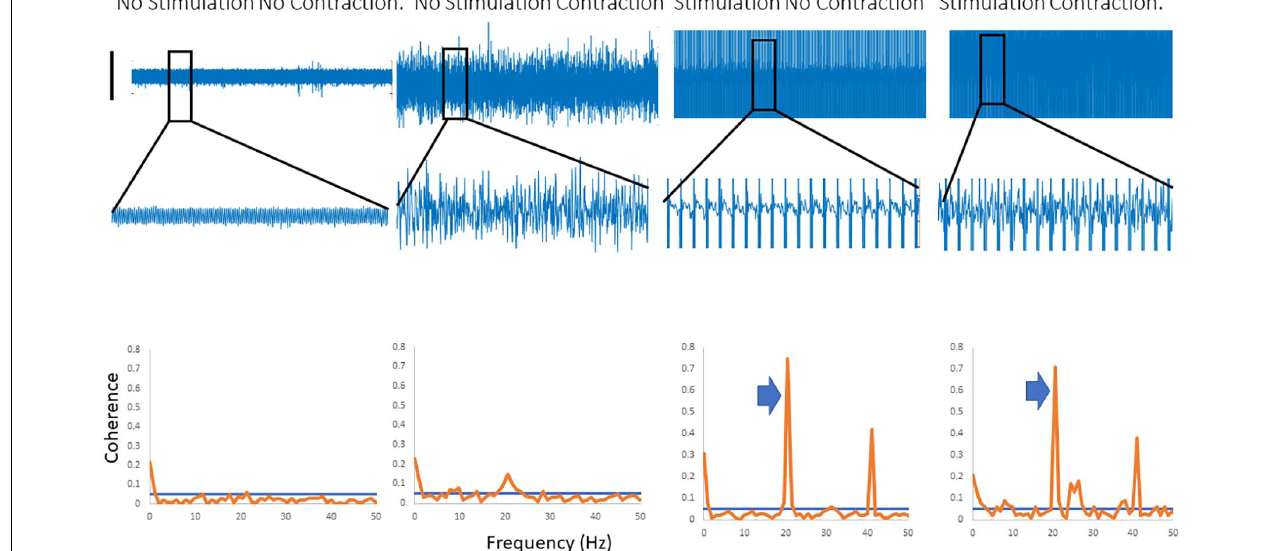
FIGURE 2 | Four columns of data from the arm are shown in this figure. Row 1 has raw EMG from the stimulated muscle, while row 2 highlights an expanded portion of that EMG, and row 3 shows coherence between the stimulated and the unstimulated, synergistic muscle. In the first column there is no activity, and hence no coherence. The second column has a background contraction, but no stimulation while the third column has stimulation but no contraction. The fourth column shows both stimulation and contraction simultaneously. In the coherence plots the arrows indicate the peak in the coherence as a result of the stimulation.